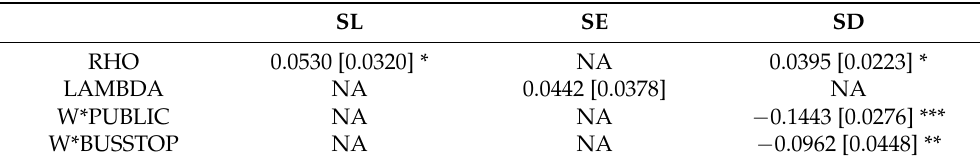
Table 5. Estimates of the spatial autocorrelation parameters for a-spatial and spatial-PD-STIRPAT models.